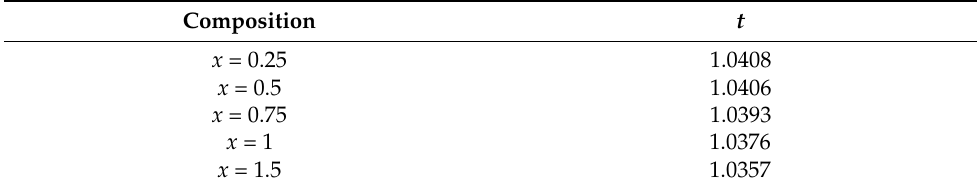
Table 2. Tolerance factors and differences for several different